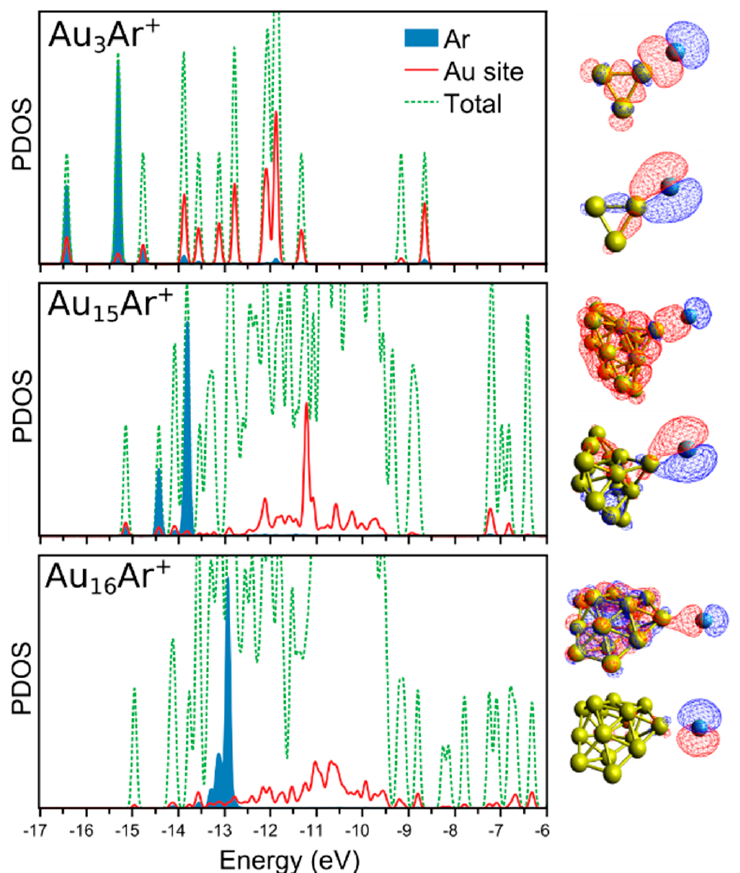
Figure 6. Density of states (DOS) of Au 3 Ar + , Au 15 Ar + and Au 16 Ar + clusters. The total DOS is presented by the dotted green lines, whereas the DOS projected (PDOS) onto the states of the Au adsorption site and the Ar atom are shown by the red lines and filled blue curves, respectively. At the right, plots of two selected Kohn − Sham molecular orbitals with major contribution from Ar are presented for each cluster. These orbitals are located at energies of − 16.4 and − 15.3 eV for Au 3 Ar + , − 15.1 and − 14.4 eV for Au 15 Ar + , and − 13.1 and − 12.9 eV for Au 16 Ar + , in the corresponding PDOS. The level of hybridization between the states of Au and Ar in the PDOS of Figure 6 are quantified by the Kullback–Leibler ( D KL ) divergence. The D KL divergence is a